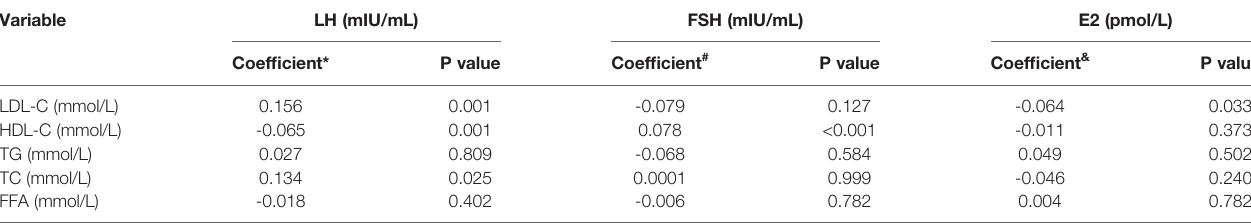
TABLE 2 | Correlations of lipid pro fi le with LH or FSH in patients with T2DM aged 51-60 years.